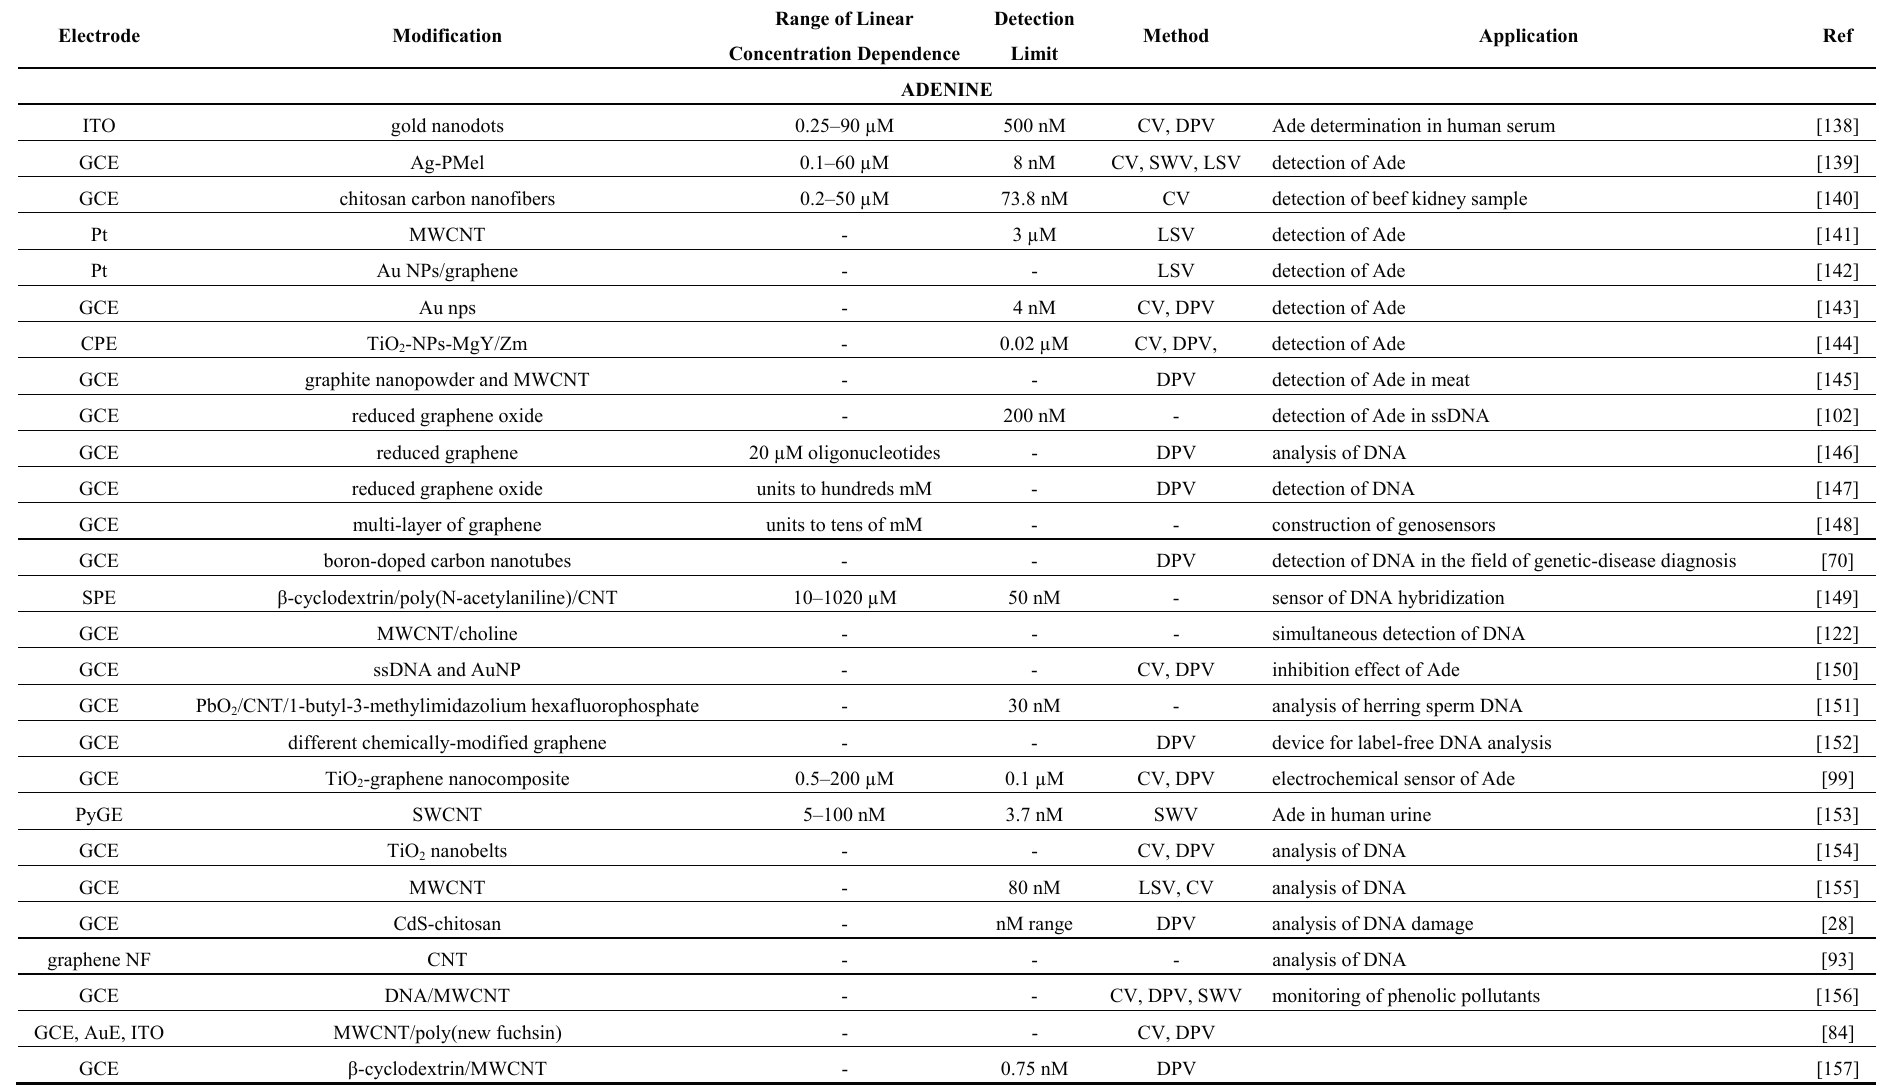
Table 4. Determination of purine derivatives on modified